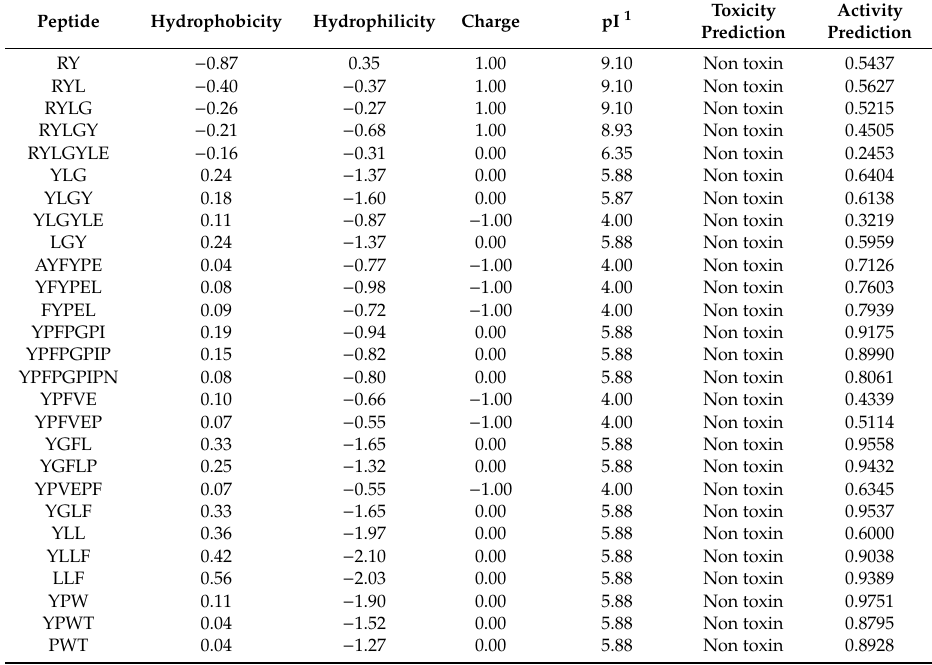
Table 2. Physicochemical characteristics and predicted biological activity and toxicity of synthetic peptides derived from food sources (PeptideRanker and ToxinPred databases). Peptide